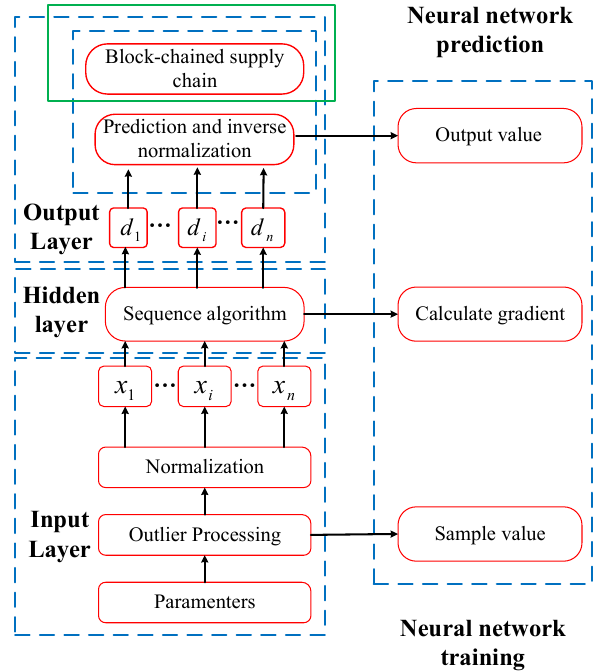
Figure 10. Prediction flow based on sequence prediction neural network.